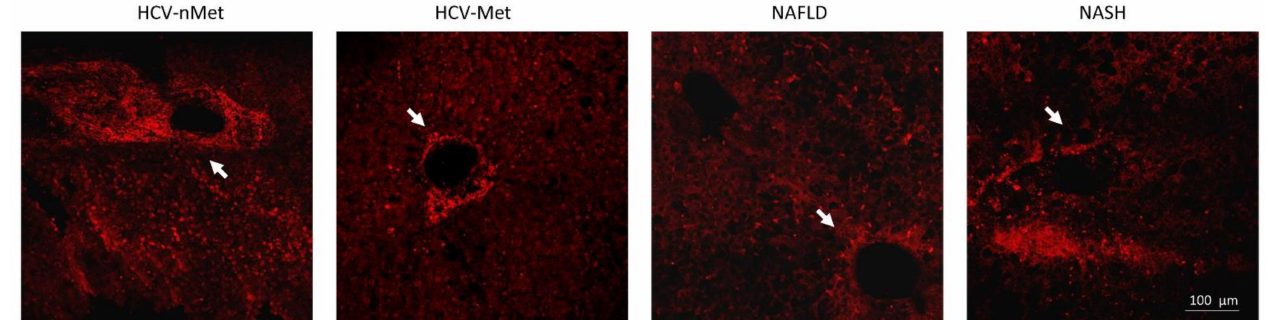
Figure 5. P2X7R immunoreactivity in the four groups of patients: in the presence of HCV infec- tion, P2X7R surrounds vessels with a fibrillar aspect; in NAFLD/NASH groups, it appears more widespread in the tissue. White arrows indicate a centrilobular vein, where P2X7R immunoreactivity is evident. The image is representative of experiments performed in 6 biopsies for each group. High magnification images using all combinations of primary antibodies clarified the different cellular localization of the inflammasomes: AIM2, not NLRP3, resulted expressed in CD68 + cells (AIM2 + /CD68 + cells: 18.3% and NLRP3 + /CD68 + : 0.6%) (Figure 6a,b), while